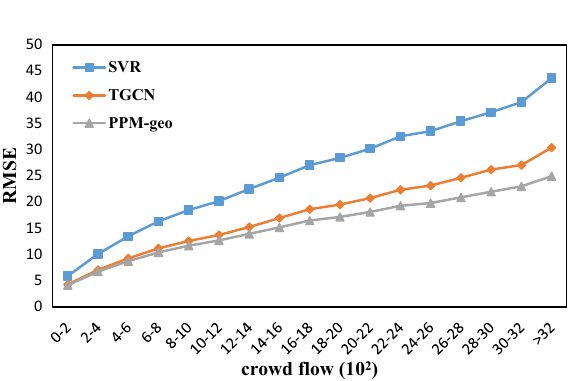
Figure 13. RMSE distributions based on the number of people in the